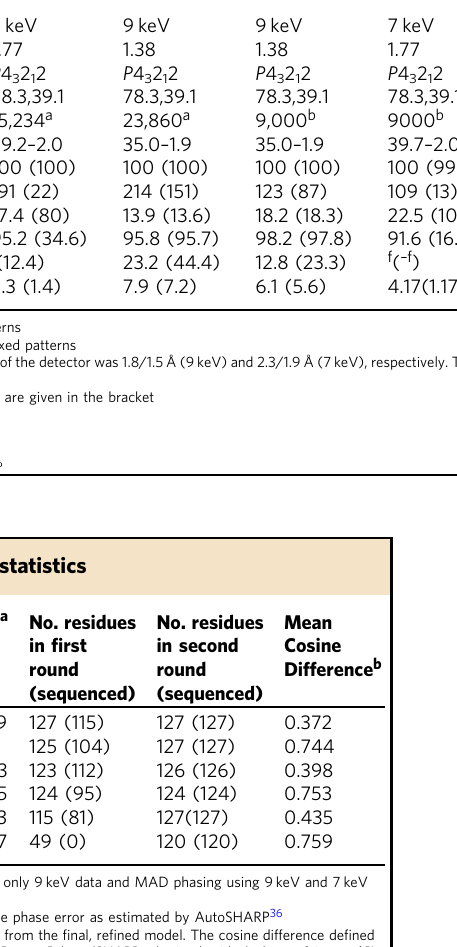
Fig. 2 Data quality. Dependence of the fi nal AutoSHARP 36 fi gure of merit before solvent fl attening for centric ( dashed lines ) and acentric re fl ections ( solid lines ) in the SAD ( red ) and MAD ( black ) cases, using 5000 indexed